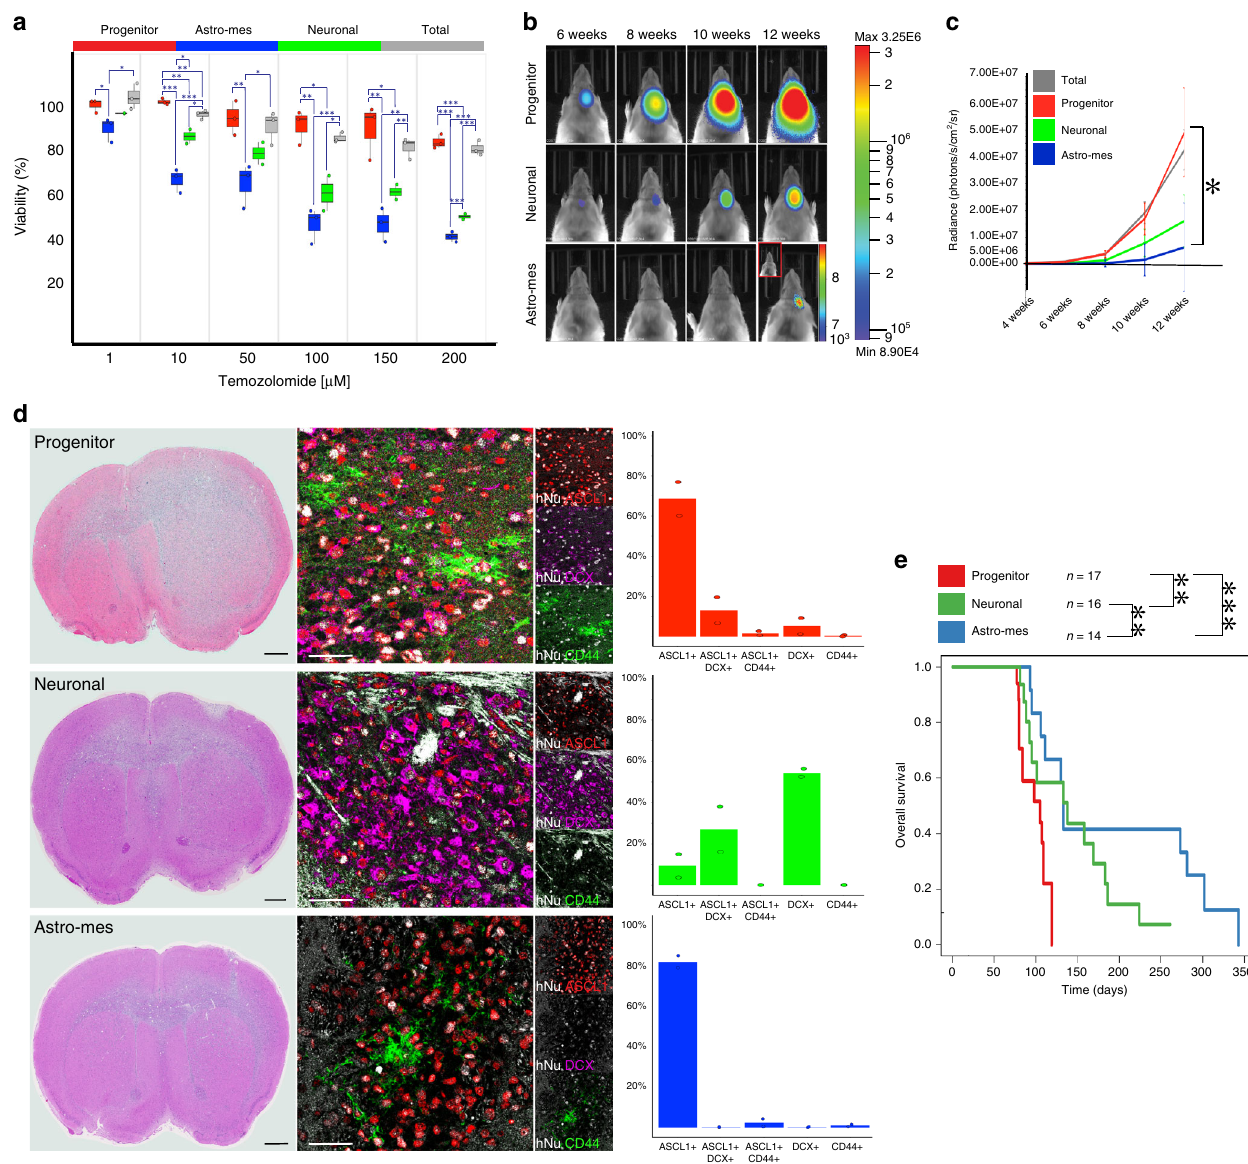
Fig. 6 Progenitor cancer cells are drivers of chemoresistance and tumor growth. a Box – whisker plots showing the proportion of viable glioma stem cells (GSCs, n = 1 patient: BT390-GSC) sorted by type and followed by 5 days of temozolomide (TMZ) treatment, normalized to corresponding vehicle control. See Supplementary Fig. 5e for additional patients. Three technical replicates and three biological replicates were performed per condition. Box plot represents the fi rst quartile, median, and third quartile with whiskers corresponding to 1.5 times the interquartile range. The overlaid dot-plots represent the mean value per biological replicate per group. A one-tailed, two-sample equal variance t test was used. b Select bioluminescence images from mice implanted with GSCs sorted by type. Mice implanted with progenitor GSCs exhibit a more rapid tumor growth compared with those implanted with neuronal or astrocytic GSCs. c Average bioluminescence intensity over time for mice xenografts injected with different GSC types sorted from BT333-GSC ( n = 24). Data are represented as mean ± SE. p values obtained with two-tailed, two-sample t tests. d Mice from each GSC group was killed at 12 weeks and the corresponding H&E and immuno fl uorescence images for cell type markers are shown. Expression of cell type-speci fi c markers was quanti fi ed from ~1000 to ~3000 human nucleoli (hNu)-positive cells per mouse model group. Each graph represents n = 2 biologically independent mouse brain sections. Scale bars: whole mount images: 1 mm; immuno fl uorescence images: 50 μ M . e Kaplan – Meier survival curves for mice implanted with different GSC types ( n = 47). Univariate Cox proportional Hazard Model (two-sided) shows a signi fi cant difference in survival between progenitor GSC and neuronal ( p value = 0.0025) or astrocytic GSC ( p value = 5.7e-6) xenografts, and also between neuronal and astrocytic GSC xenografts ( p value = 0.0059). For all plots, *** p < 0.001, ** p < 0.01, * p <